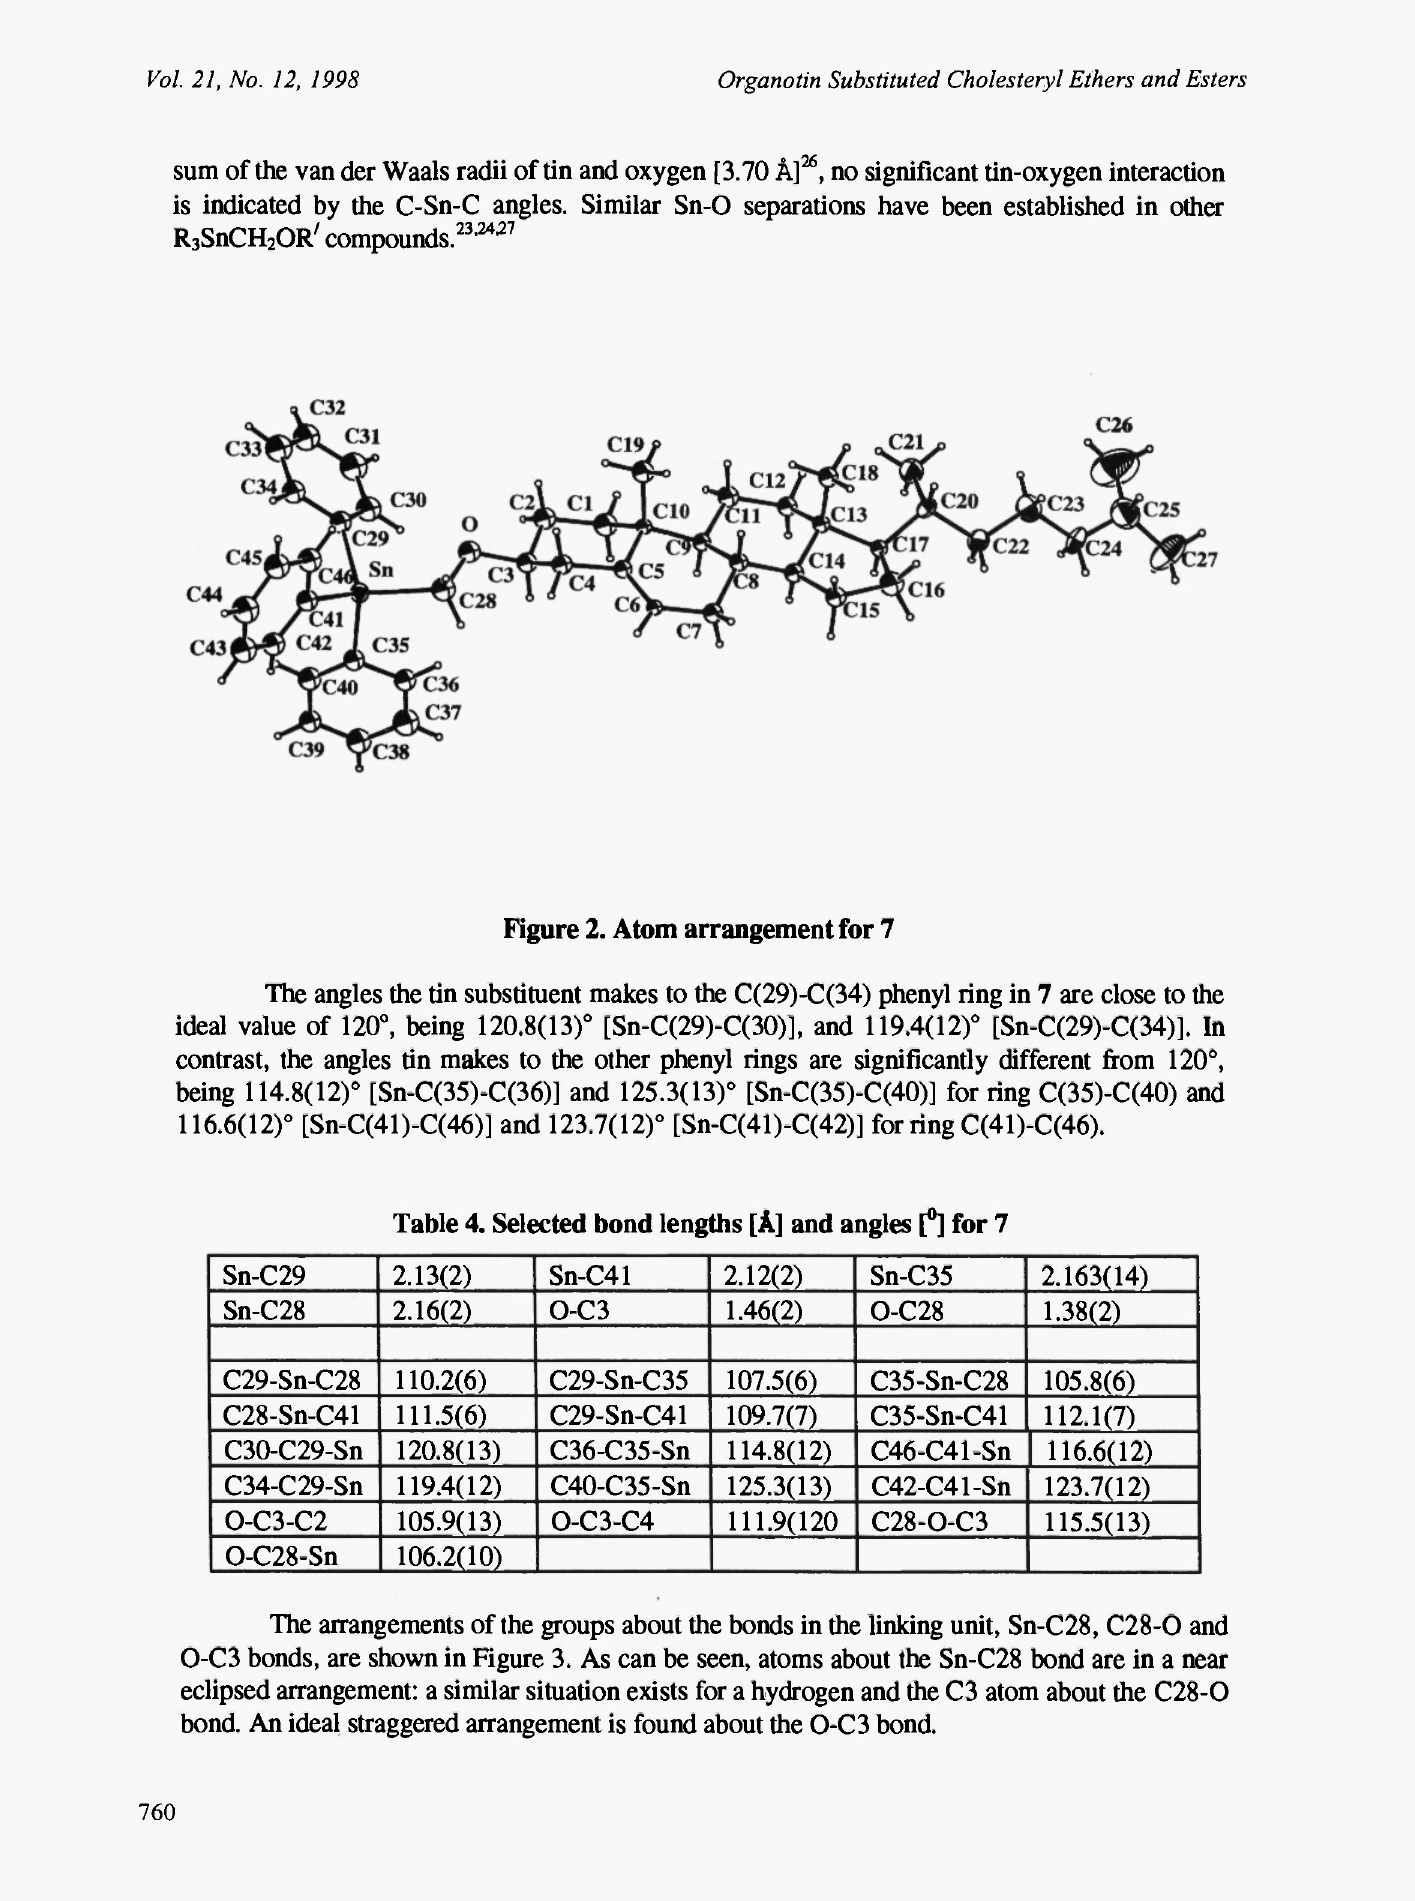
Table 4. Selected bond lengths [A] and angles [°] for